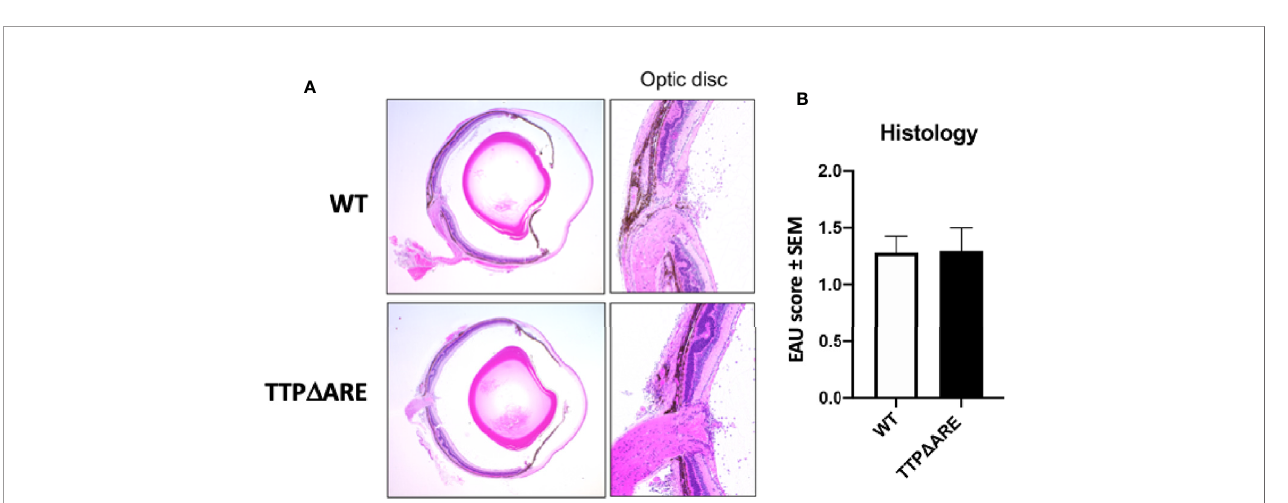
FIGURE 6 | TTP D ARE mice resemble their WT controls in development of experimental autoimmune uveitis (EAU) by adoptive transfer. Naive mice from the two genotypes were injected with 50 million T-cells speci fi c to the IRBP peptide 651-670, from immunized C57BL/6N donor mice, and the presence and severity of EAU were determined by histological analysis of eyes after euthanasia on day 9 post cell injection. (A) shows that the eyes from both genotypes of mice exhibited similar pathological changes, including mild retinal folding and in fi ltration of in fl ammatory cells into the optic nerve head, retinal tissues and vitreous. (B) shows the pathological changes. The Mann-Whitney U test was used for statistical comparison. Combined data from two